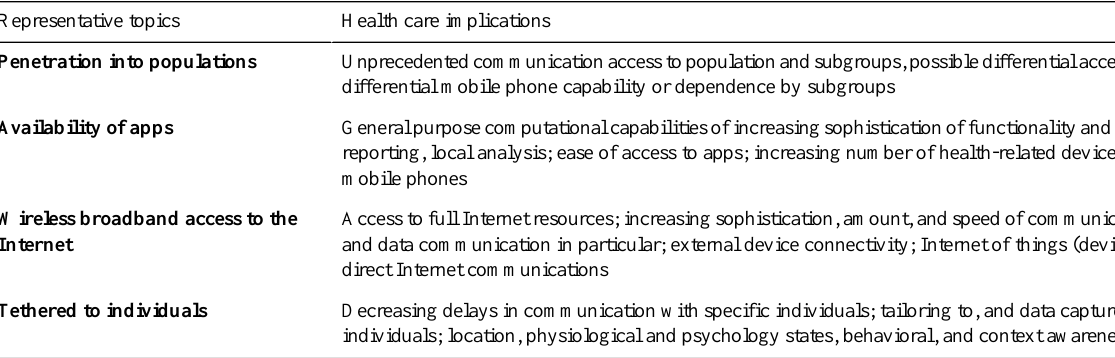
Table 2. mHealth core characteristics for health care. Health care implicationsRepresentative topics Unprecedented communication access to population and subgroups, possible differential access by subgroups, differential mobile phone capability or dependence by subgroups General purpose computational capabilities of increasing sophistication of functionality and data